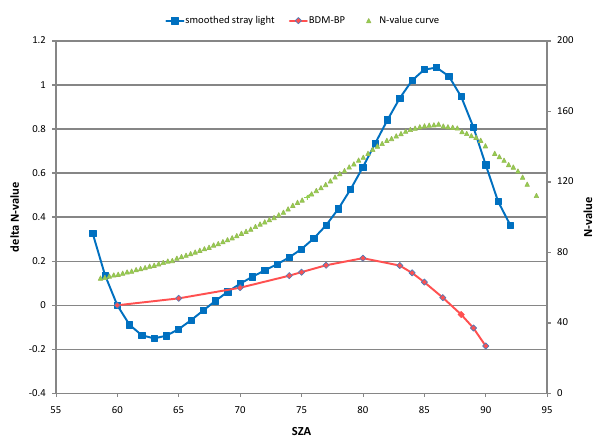
Fig. 1. Solar zenith angle shape of the out-of-band light contribu- tion to Umkehr measurements by Dobson No. 065 obtained in Boul- der on 4 April 2008. Total ozone is 360DU. The blue squares are smoothed change in Dobson C-pair measurements (delta N-values, left-side axes) associated with the out-of-band stray light compared to measurements without stray-light contribution, whereas green tri- angles show measured Umkehr curve (N-value, axes on the right side). The difference between N-values simulated with BP and BDM ozone absorption cross-sections is shown as red diamonds (delta N-value, left-side